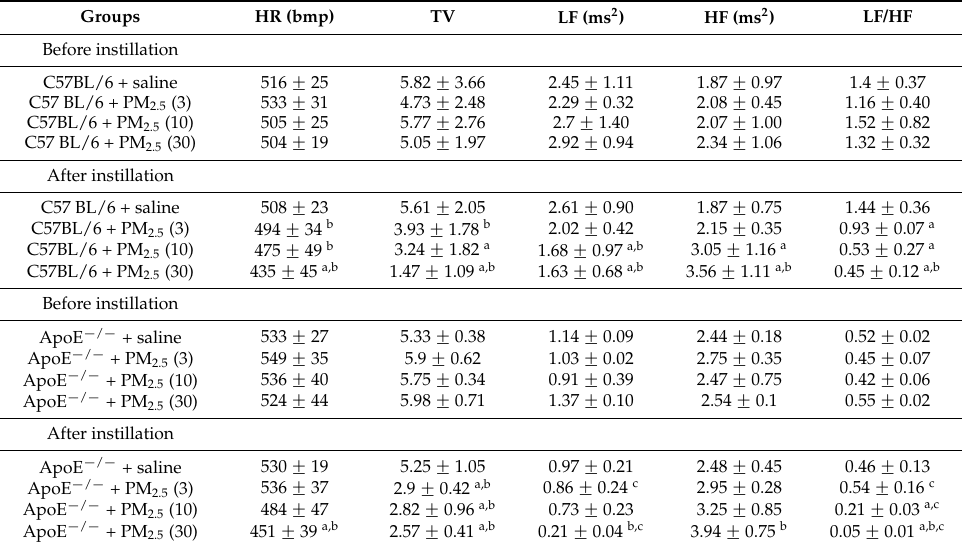
Table 3 Changes in heart rate and HRV indices in mice after exposed to PM 2.5 . The doses were 0 (control), 3, 10, and 30 mg/kg b.w. Significant difference ( a p < 0.05) between PM 2.5 group and control group, significant difference ( b p < 0.05 ) between before instillation and after instillation by self-control, and significant difference ( c p < 0.05) between C57BL/6 and dose- matched ApoE − / − mice were observed.